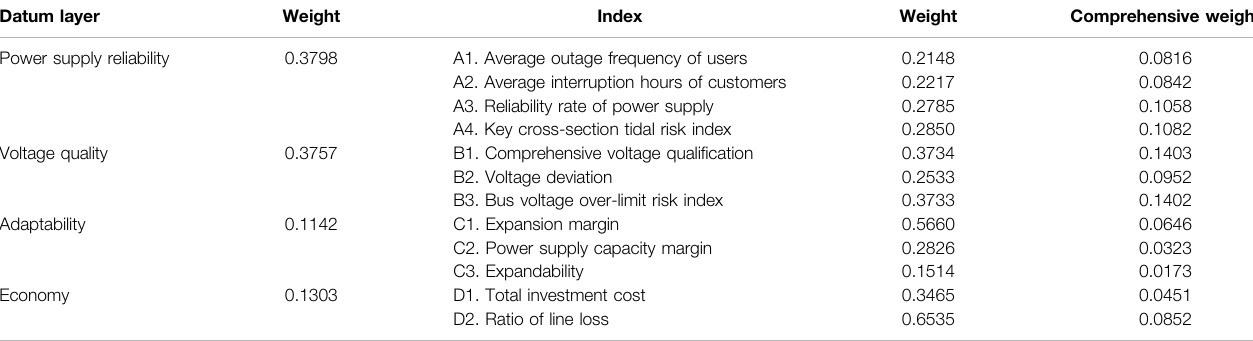
TABLE 4 | Calculation results of benchmark layer weight, index layer weight, and comprehensive weight. Datum layer